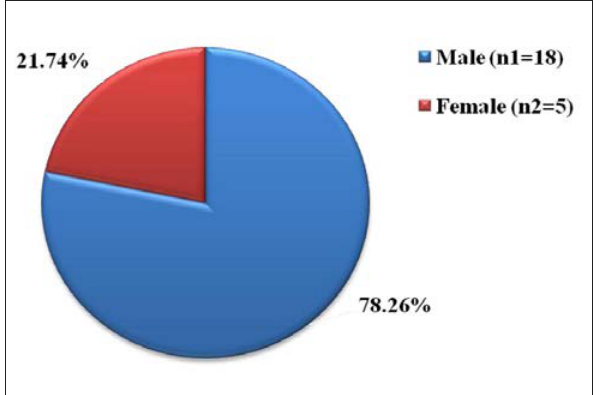
Figure-2: Sex wise analysis of positive